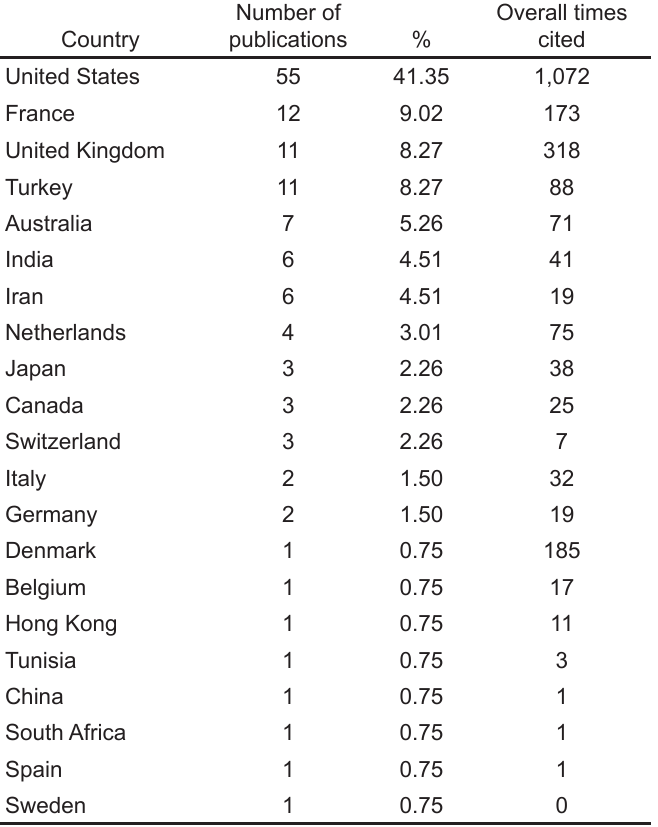
Table 1 . Country distribution in regional anesthesia-related publications by the number of publications.